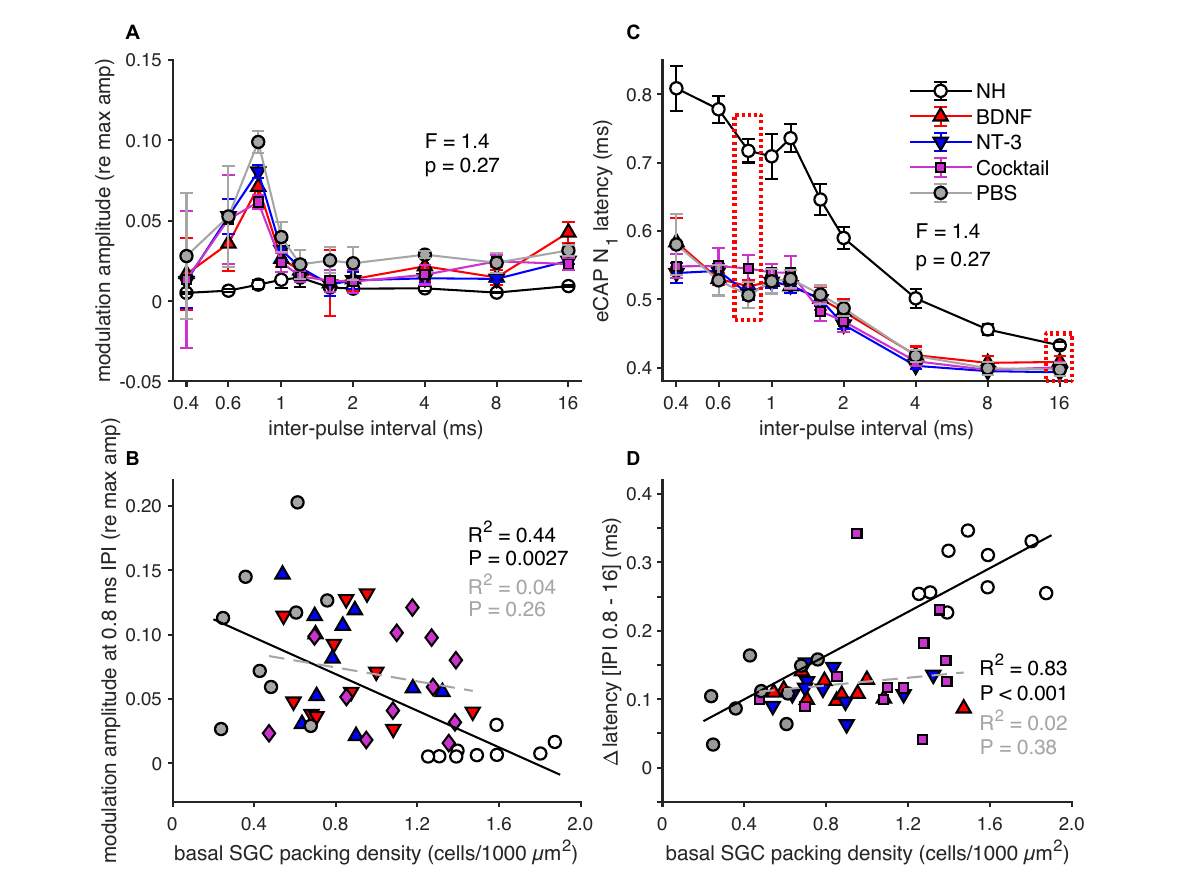
FIGURE9 eCAP parameters derived from the responses to the last ten pulses of a 100-ms pulse train. (A) Group means of the normalized eCAP amplitude modulation as a function of IPI for all ten pulses. (B) Group means of eCAP N 1 latency as a function of IPI for all ten pulses. (C) Amplitude modulation for an IPI of 0.8 ms for all individual animals as a function of basal SGC packing density, regression was performed on the NH and PBS animals only. (D) (cid:49) N 1 latency between 0.8 and 16 ms, for the individual animals as a function of SGC packing density. The regression was calculated on the NH and PBS animals only. NH, n = 9; PBS, n = 9; BDNF, n = 11; NT-3, n = 11; Cocktail, n = 12. Error bars represent